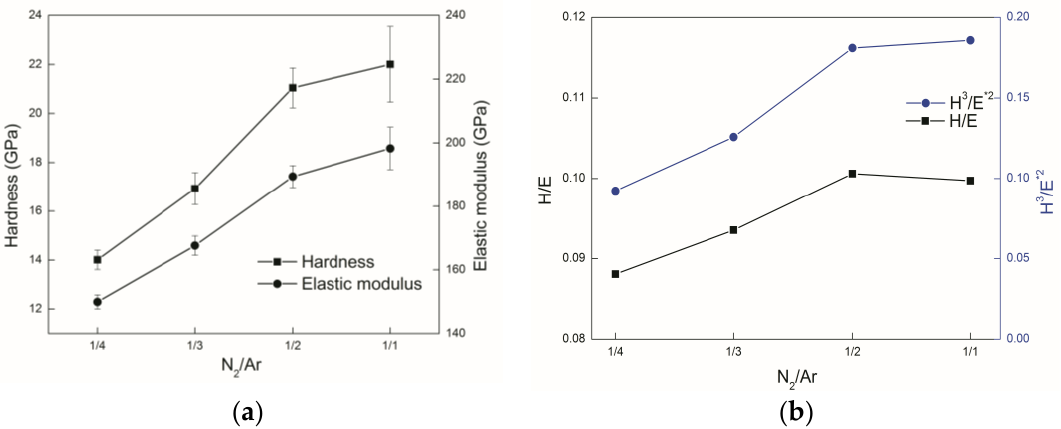
Figure 5. ( a ) Micro-hardness, elastic modulus and H / E and H 3 / E * 2 values of the Al-Cr-Si-N films as a function of N 2 /Ar flow ratio hardness and elastic modulus of coatings; ( b ) H / E ratio and H 3 / E * 2 values of coatings.